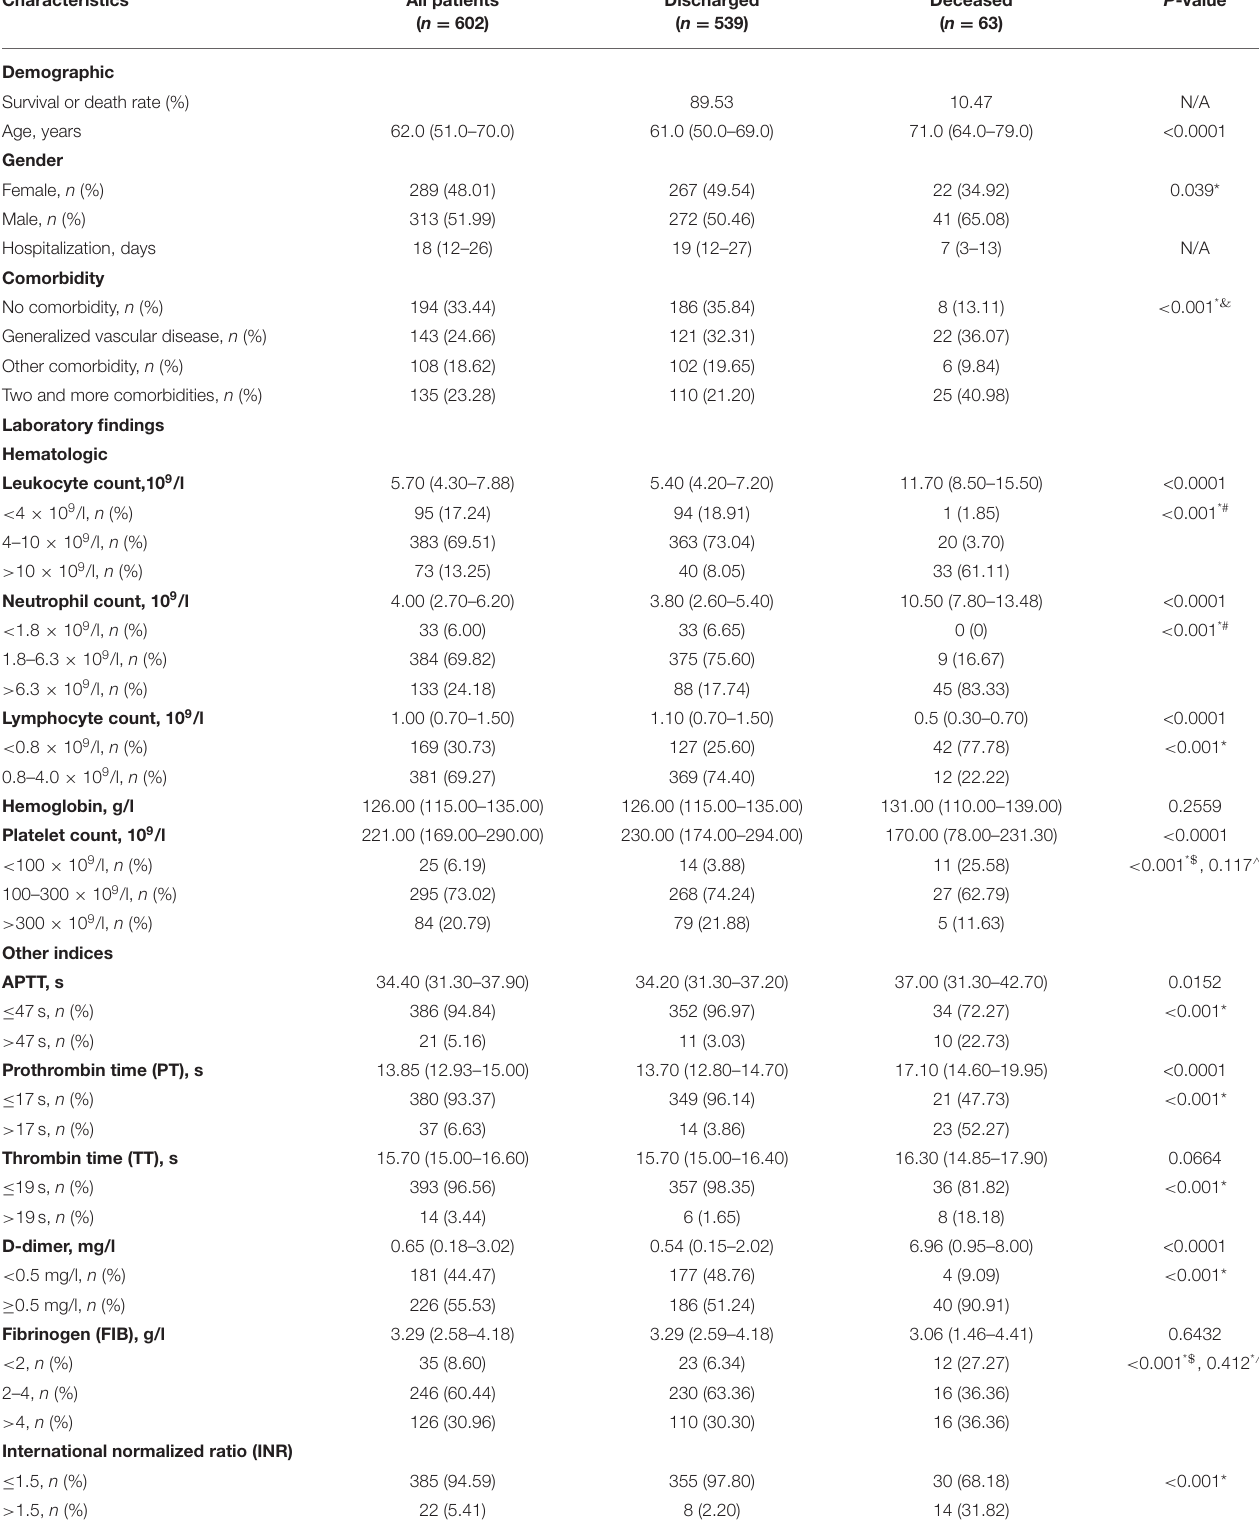
TABLE 1 | Baseline characteristics of the recovered patients and patients who died of COVID-19.